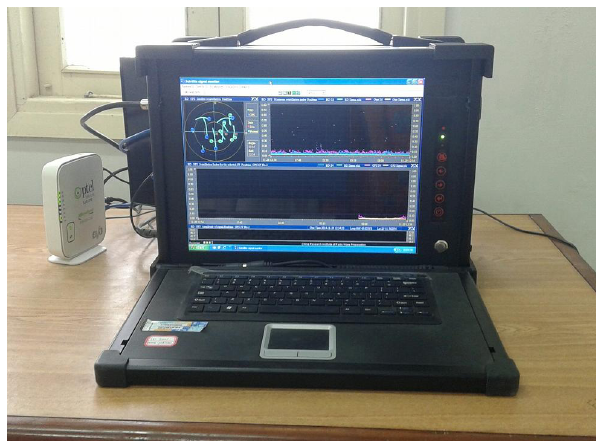
Figure 9. Ionospheric scintillation monitor. PC with “Satellite Sig- nal Monitor” software installed.